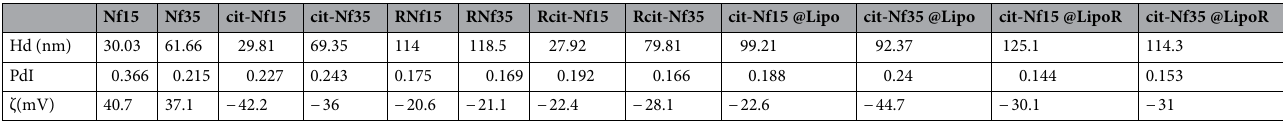
Table 1. DLS data from all nanoformulations; hydrodynamic diameter (d H ), polydispersity index (PdI) and zeta potential (ζ).